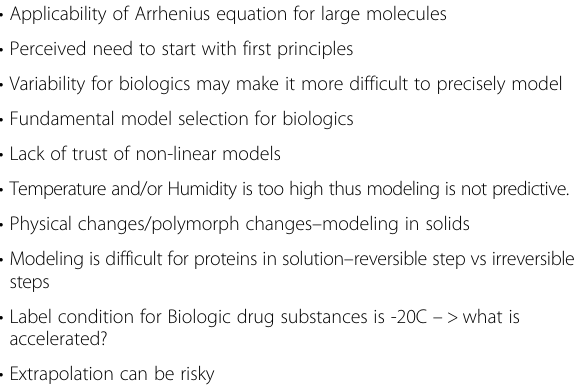
Table 2 Unique issues for large versus small molecules